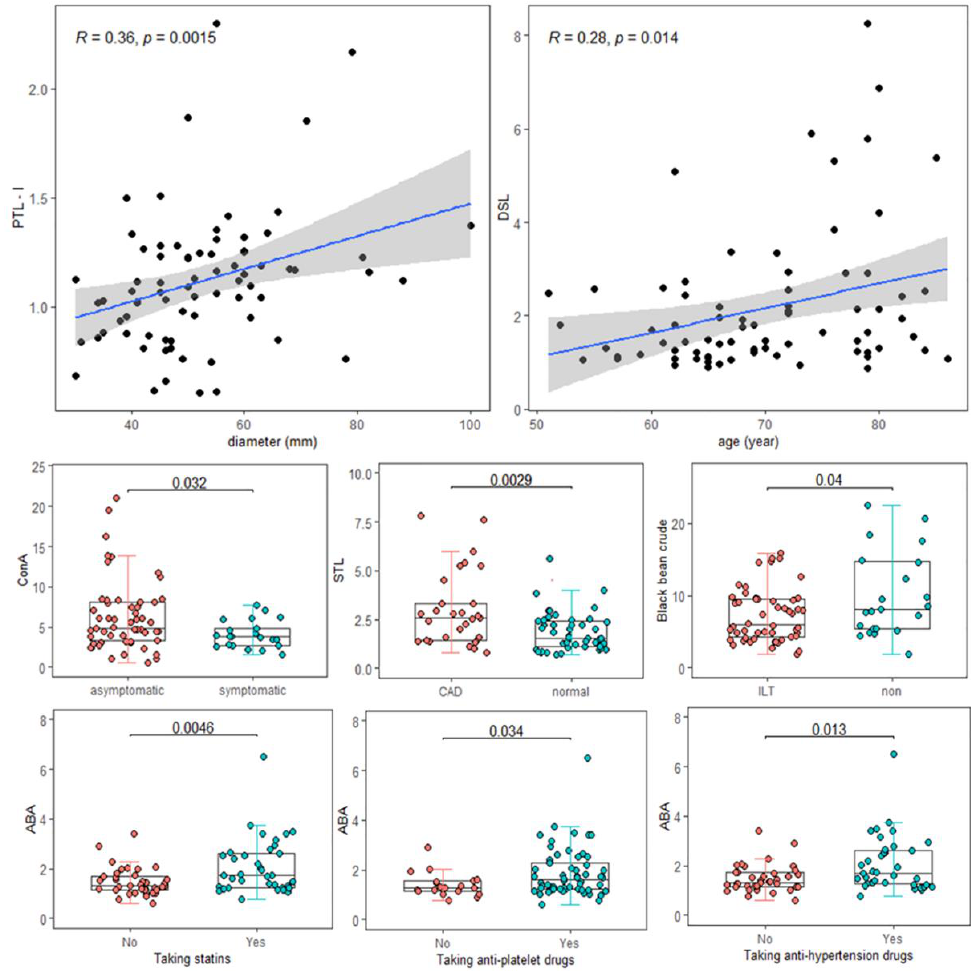
Figure 4. Clinical correlation of lectins with significant results from microarray. CAD, coronary heart disease. ILT, intraluminal thrombus. All AAA subjects were divided into two groups according to the presence of one factor (e.g., symptomatic) for intra-group analysis.